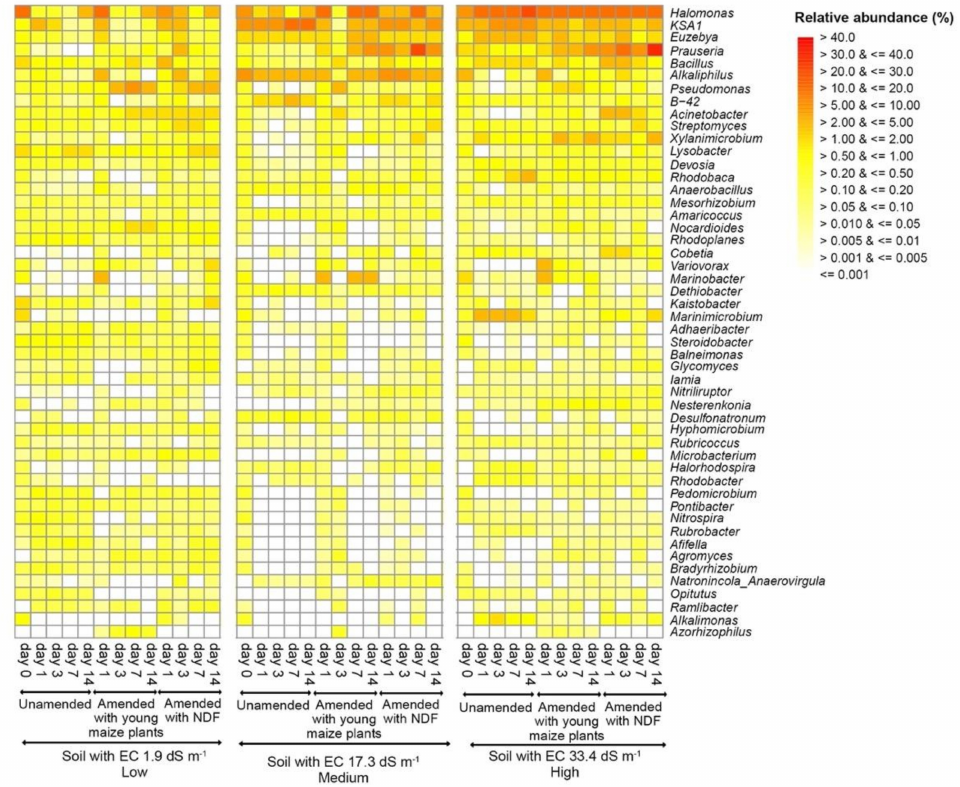
Figure 2. Heatmap with the relative abundance (%) of the 50 most abundant genera in the three soils from the former lake Texcoco with different electrolytic conductivity (EC) left unamended or amended with young maize plants and their neutral detergent fiber (NDF) fraction at the onset of the experiment (day 0) and incubated aerobically at 22 ± 2 ◦ C for one (day 1), three (day 3), seven (day 7), or 14 days (day 14).